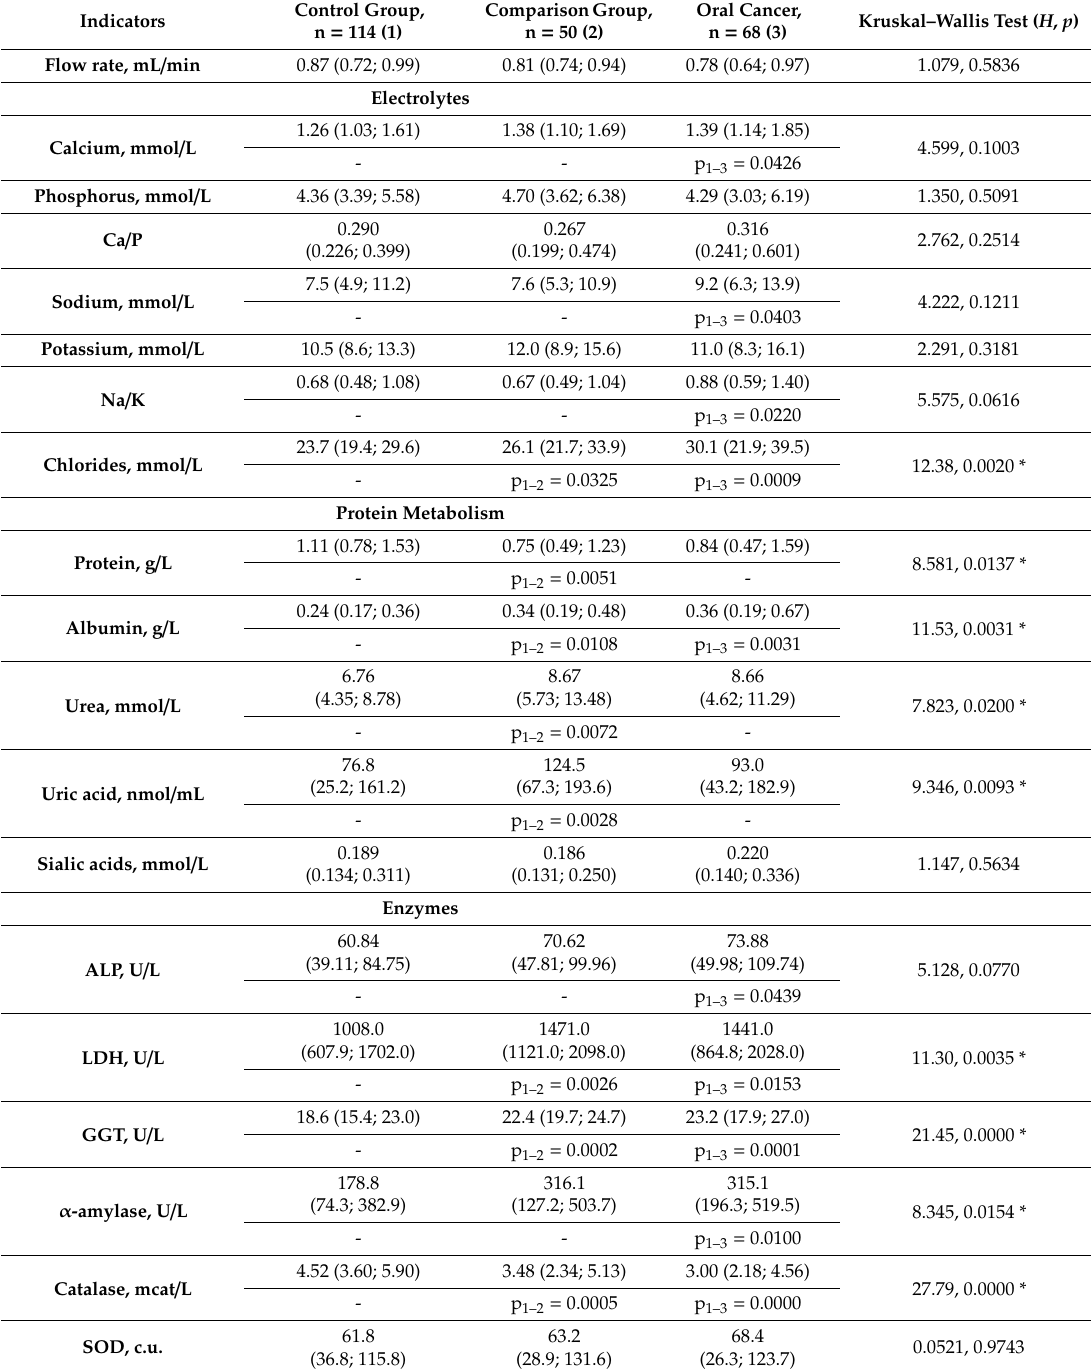
Table 1. The results of biochemical analysis of the studied